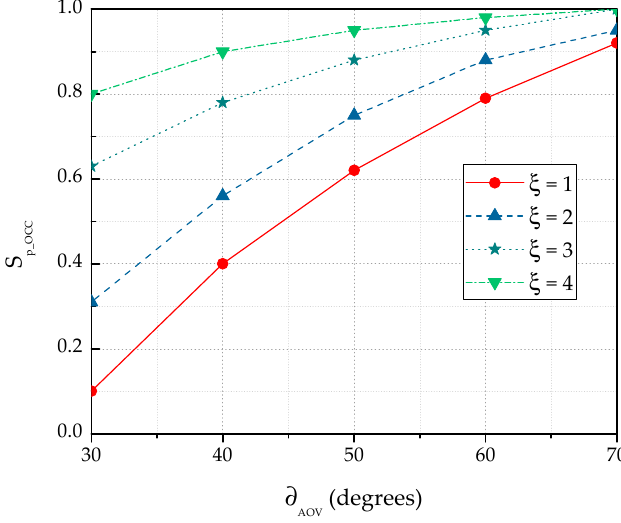
Figure 7. Variation of OCC selection probability for the single- and multiple-camera scenarios. Sensors 2019 , 19 , x FOR PEER REVIEW